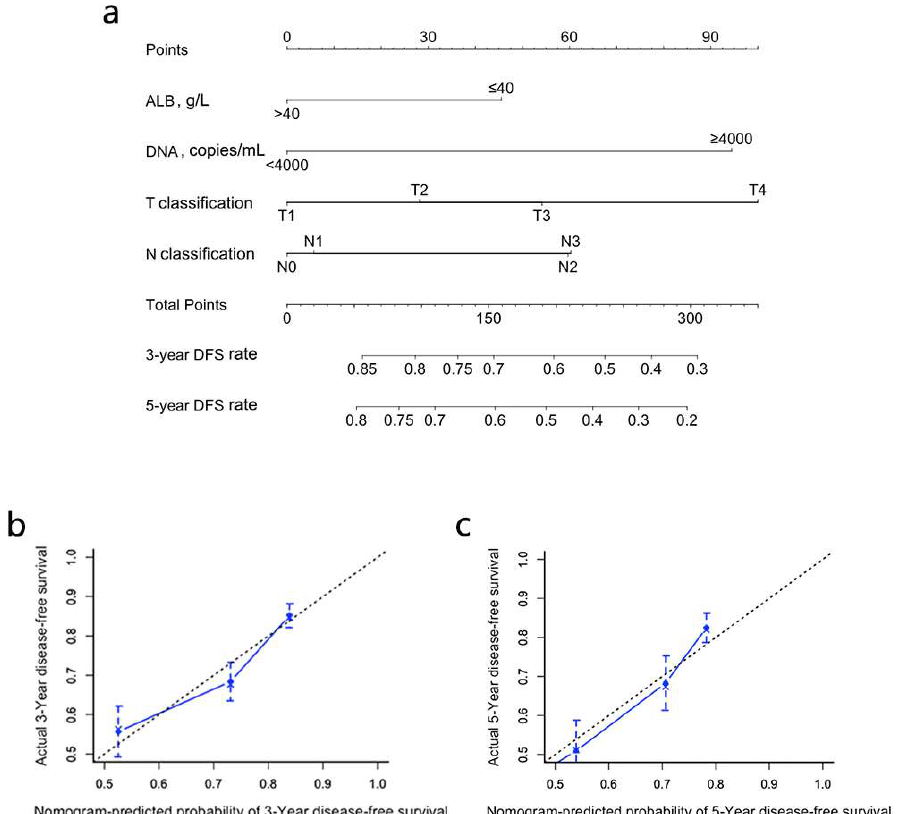
Figure 2. Prognostic nomogram ( a ) and calibration plots ( b,c ) for 3-year and 5-year DFS in elderly patients with LA-NPC. The X -axis represents the probability of 3-year DFS predicted by the nomogram and the Y -axis represents the actual observed probability of 3-year DFS. The dotted line indicates that the predicted and observed survival probability is consistent. NPC, nasopharyngeal carcinoma; EBV, Epstein–Barr virus; ALB, albumin; DFS, disease-free survival; OS, overall survival. Table 2. C-index and AUC of prognostic model and single risk factors for predicting DFS in elderly patients with LA-NPC.